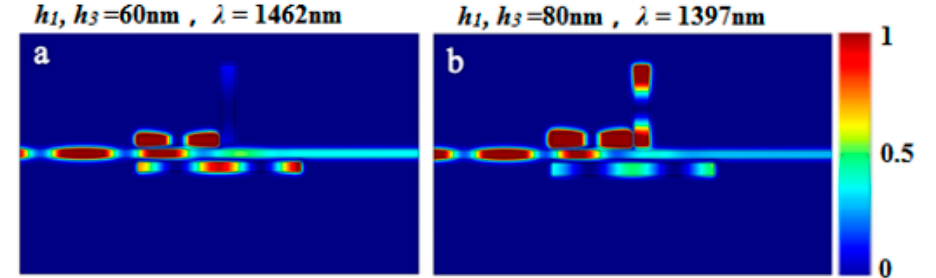
Figure 9. The field distribution |Hz| 2 of the structure at ( a ) incident wavelength 1462 nm when h 1 ,